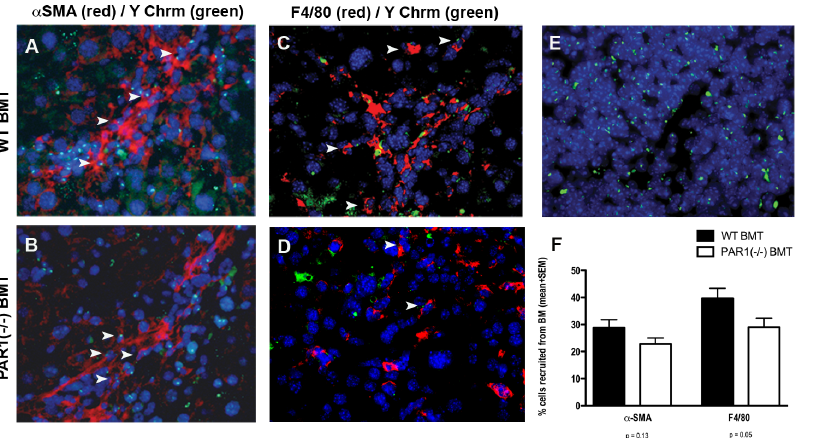
Figure 4. Absence of PAR1 signalling on BM-derived cells is associated with a significant reduction in macrophage recruitment to the injured liver. Female C57/BL6 mice received BMT from male PAR1 knockout donors (PAR1( 2 / 2 )BMT, B&D) or from male C57/BL6 WT controls (WTBMT, A&C) before CCl 4 liver injury. In both groups, BM-derived myofibroblasts ( a SMA, red, A&B) and hepatic macrophages (F4/80, red, C&D) are seen (examples indicated by white arrowheads, 6 400 magnification). (E) Splenic tissue showing complete haematopoietic reconstitution of recipient mice (female) with male cells, validating the efficacy of the BMT protocol. In all panels BM-derived (male) cells are identified by Y chromosome in situ hybridisation (green dot, Y chrm), localised within nuclei (DAPI, blue). (F) Graph showing the relative proportion of hepatic myofibroblasts ( a SMA) and macrophages (F4/80) of BM origin. There is a significant reduction of BM-derived macrophage infiltration into the liver with loss of PAR1 signalling. (n=8 per group, mean + SEM, p values as shown.)